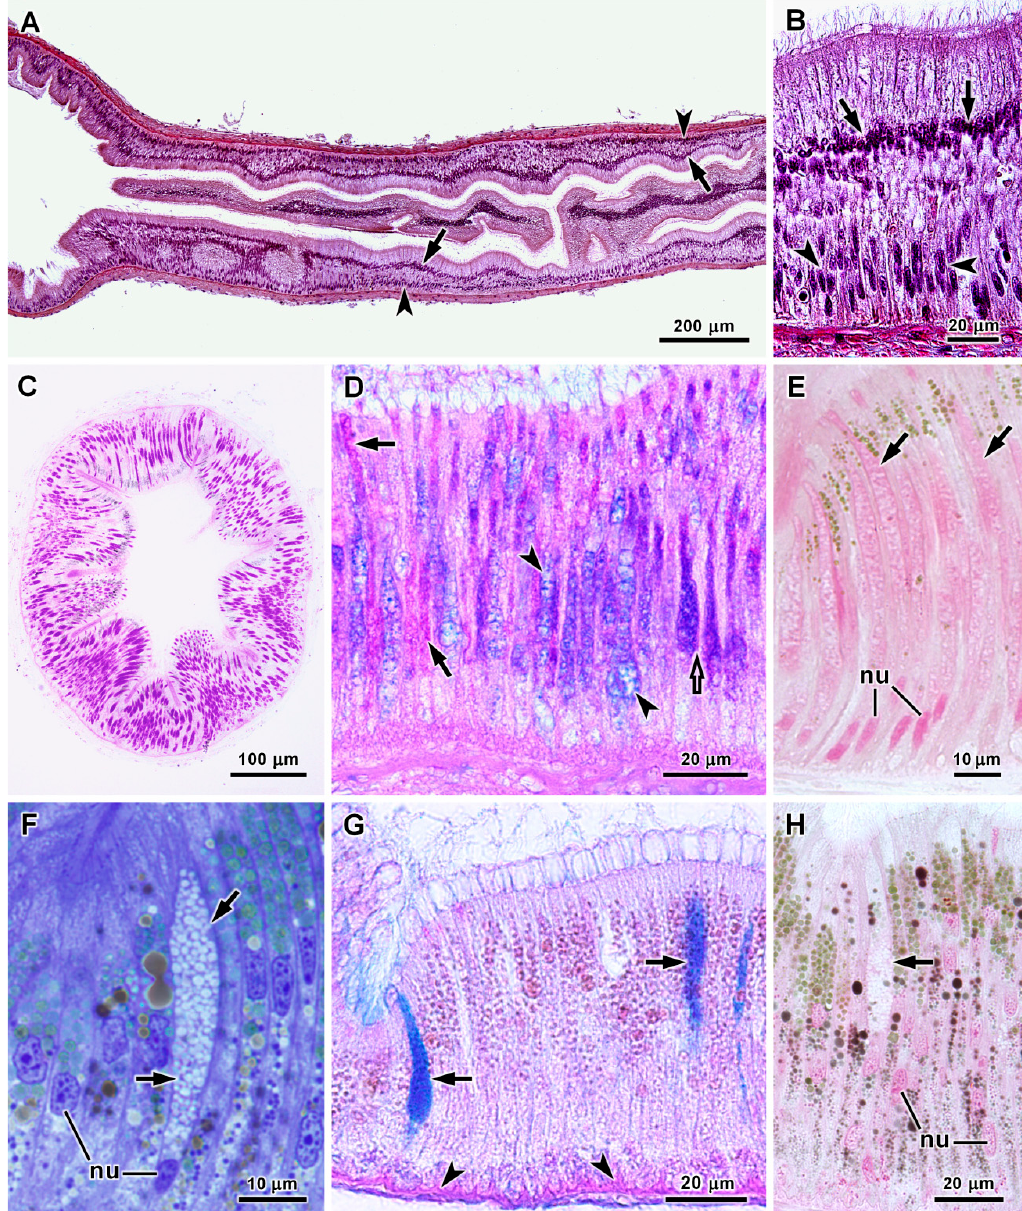
Figure 11. Intestine of A. fascicularis ( A – E ) and C. angulata ( F – H ) in histological ( A , B , D , G ) and semithin ( C , E , F , H ) sections. ( A , B ) Longitudinal (parasagittal) section of the valve between the anterior and posterior intestine of A. fascicularis stained by Masson’s trichrome. The basal row of nuclei correspond to the nuclei of mucus-secreting cells (arrowheads) and the nuclei in the upper row belong to absorptive ciliated cells (arrows). ( C ) Transverse section of the valve with the mucus-secreting cells strongly stained by PAS reaction. ( D ) In the valve epithelium some mucus-secreting cell were stained only by PAS reaction (arrows), others mostly by Alcian blue (arrowheads) and still other were stained by both (open arrow). ( E ) Mucus-secreting cells of the valve (arrows) weakly stained by the tetrazonium coupling reaction. ( F – H ) Mucus-secreting cells (arrows) in the posterior intestine of C. angulata , unstained by methylene blue and azure II ( F ), strongly stained by Alcian blue ( G ) and unstained by the tetrazonium coupling reaction ( H ). The basal lamina is stained by PAS reaction (arrowheads in G ). nu—nuclei.